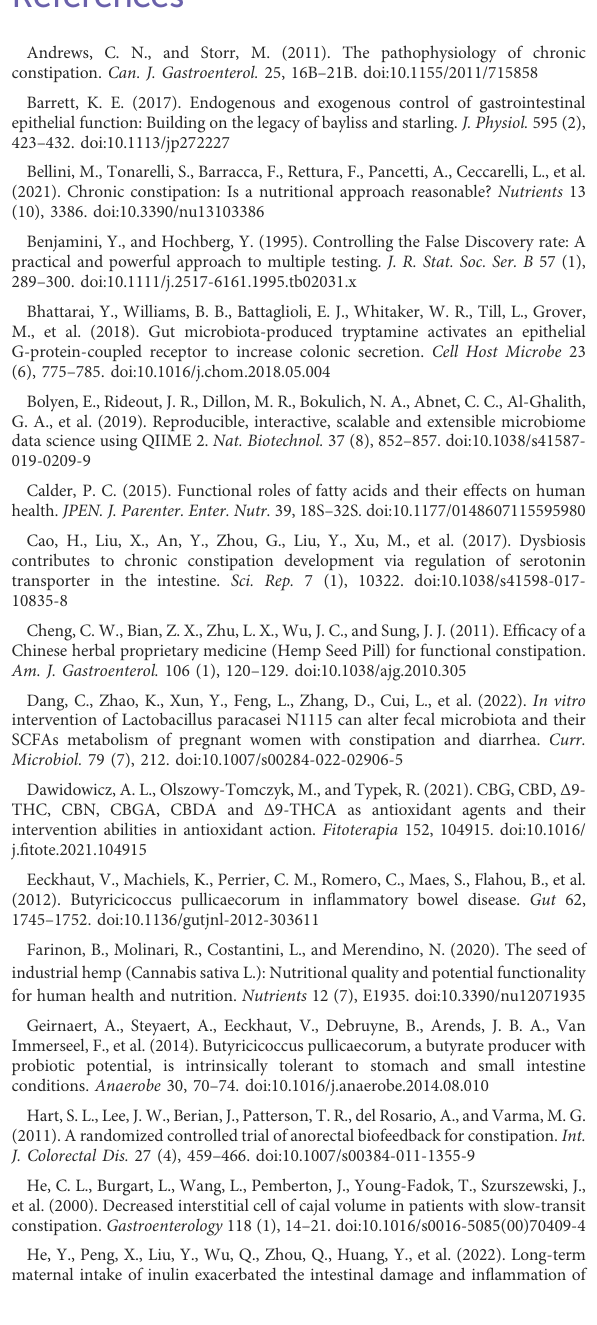
SUPPLEMENTARY FIGURE S1 The total fatty acid diagrams. Figure S2. Blood biochemical analysis